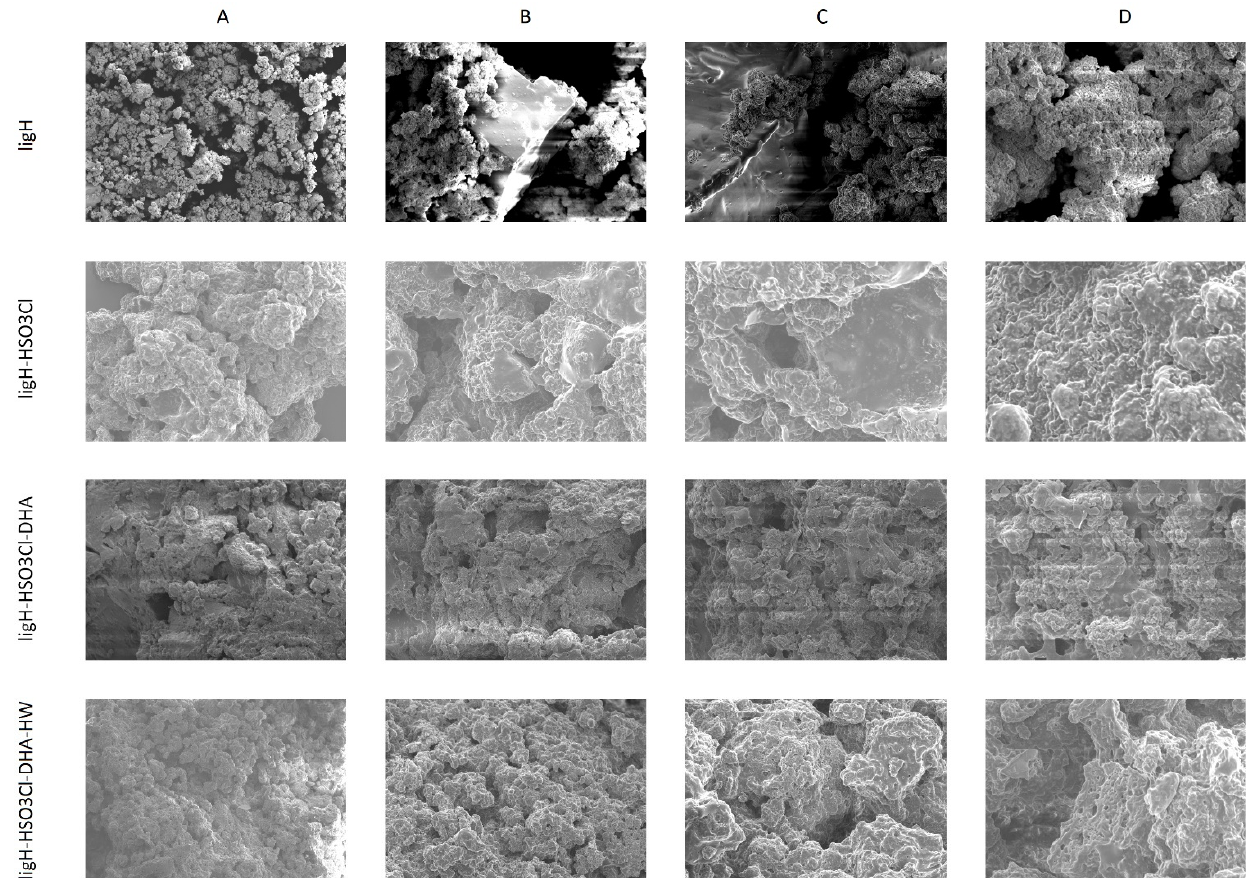
Figure 6. Morphology of the lignins obtained after both steps of the modification procedure: Column ( A ) magnification 200 × , ( B ) 500 × , ( C ) 1000 × , ( D ) 2000 × . Imaging conditions were described in Section